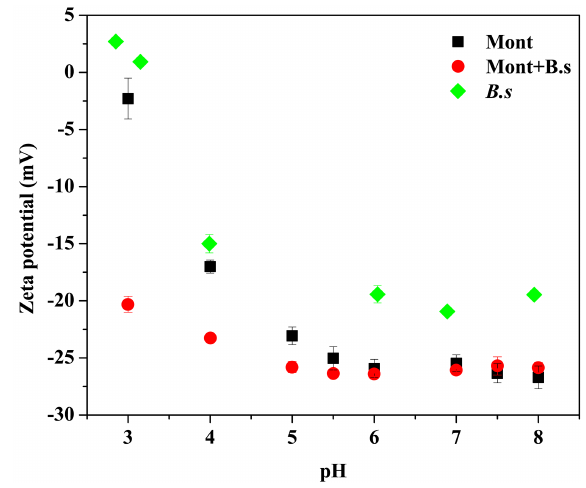
Figure 1. Zeta potential of montmorillonite, B. subtilis , and montmorillonite– B. subtilis composite at different pH